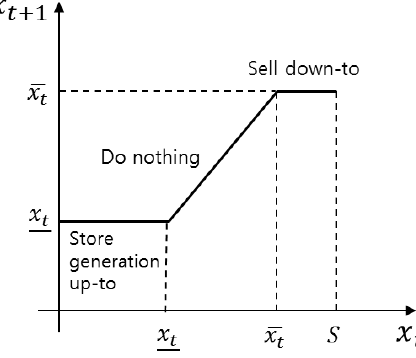
Figure 3. The structure of optimal charging/discharging action of the ESS in the case 3, ( x t , w t ) ∈ ( A 3 )